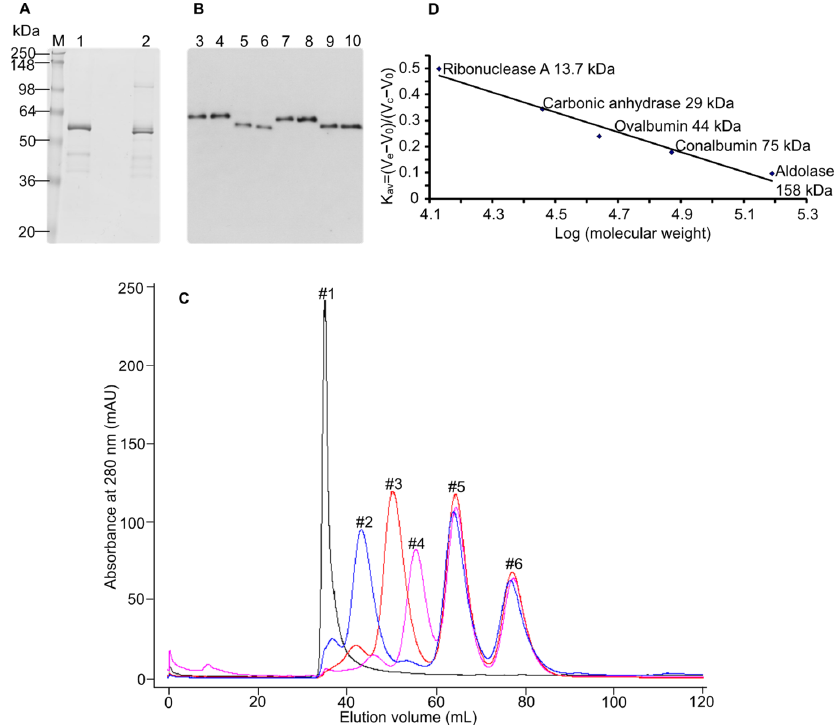
Figure 2. Mutations in the furin cleavage site prevent prodomain removal. ( A ) SDS-PAGE of the WT-MT1-MMP ectodomain (ED) expressed in drosophila S2 cells. WT-MT1-MMP ectodomain was stably transfected into drosophila S2 cells and the enzyme was purified on the IMAC column. The samples were loaded under reducing (with β -mercaptoethanol) (lane 1) and non-reducing conditions (without β -mercaptoethanol) (lane 2), M: molecular weight marker. ( B ) Western blot analysis of furin cleavage site MT1-MMP mutants. The mutants were transiently expressed in drosophila S2 cells and detected by Western blotting using an anti-His-tag antibody conjugated with HRP. Lane 3: R 108 RKR 111 → AAAA-WT-MT1-MMP-ED; lane 4: R 108 RKR 111 → AAAA-EA-MT1-MMP-ED; lane 5: R 89 → A-WT-MT1-MMP-ED; lane 6: R 89 → A-EA-MT1-MMP-ED; lane 7: R 111 → A-WT-MT1-MMP-ED; lane 8: R 111 → A-EA-MT1-MMP-ED; lane 9: WT-MT1-MMP-ED; lane 10: EA-MT1-MMP-ED. Two sets of mutants (R 111 → A and R 108 RKR 111 → AAAA) inhibited the cleavage of the prodomain from both WT-MT1-MMP-ED and EA-MT1-MMP-ED. ( C ) Chromatographic separation of the standard proteins used for the column calibration. The following markers have been used: peak #1 blue dextran—2,000,000 Da, peak #2 aldolase—158,000 Da, peak #3 conalbumin—75,000 Da, peak #4 ovalbumin—44,000 Da, peak #5 carbonic anhydrase—29,000 Da, peak #6 ribonuclease A—13,700 Da. The protein peaks were monitored at 280 nm absorption. ( D ) Calibration curve of sephacryl gel filtration column. The equation y = − 0.3808x + 2.0455 derived from the